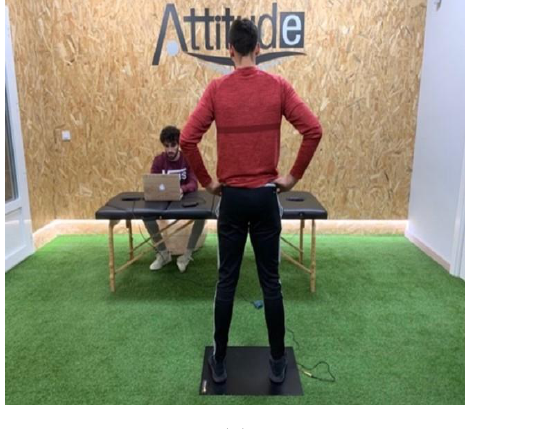
Figure 2. Countermovement jump measurement: ( a ) Starting position; ( b ) vertical jump after a fast-down countermove- ment.